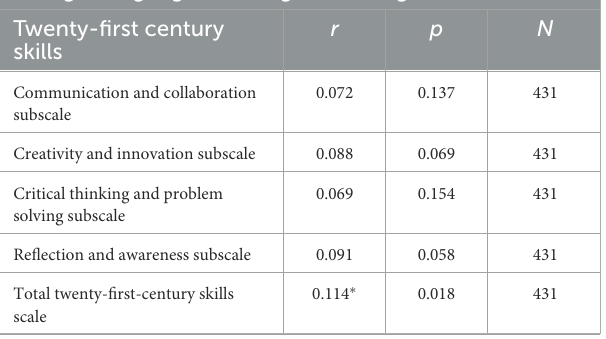
TABLE 9 Correlations between the total twenty-first-century skills scale scores, scores obtained from the subscales of the twenty-first-century skills scale, and the foreign language learning technologies scale